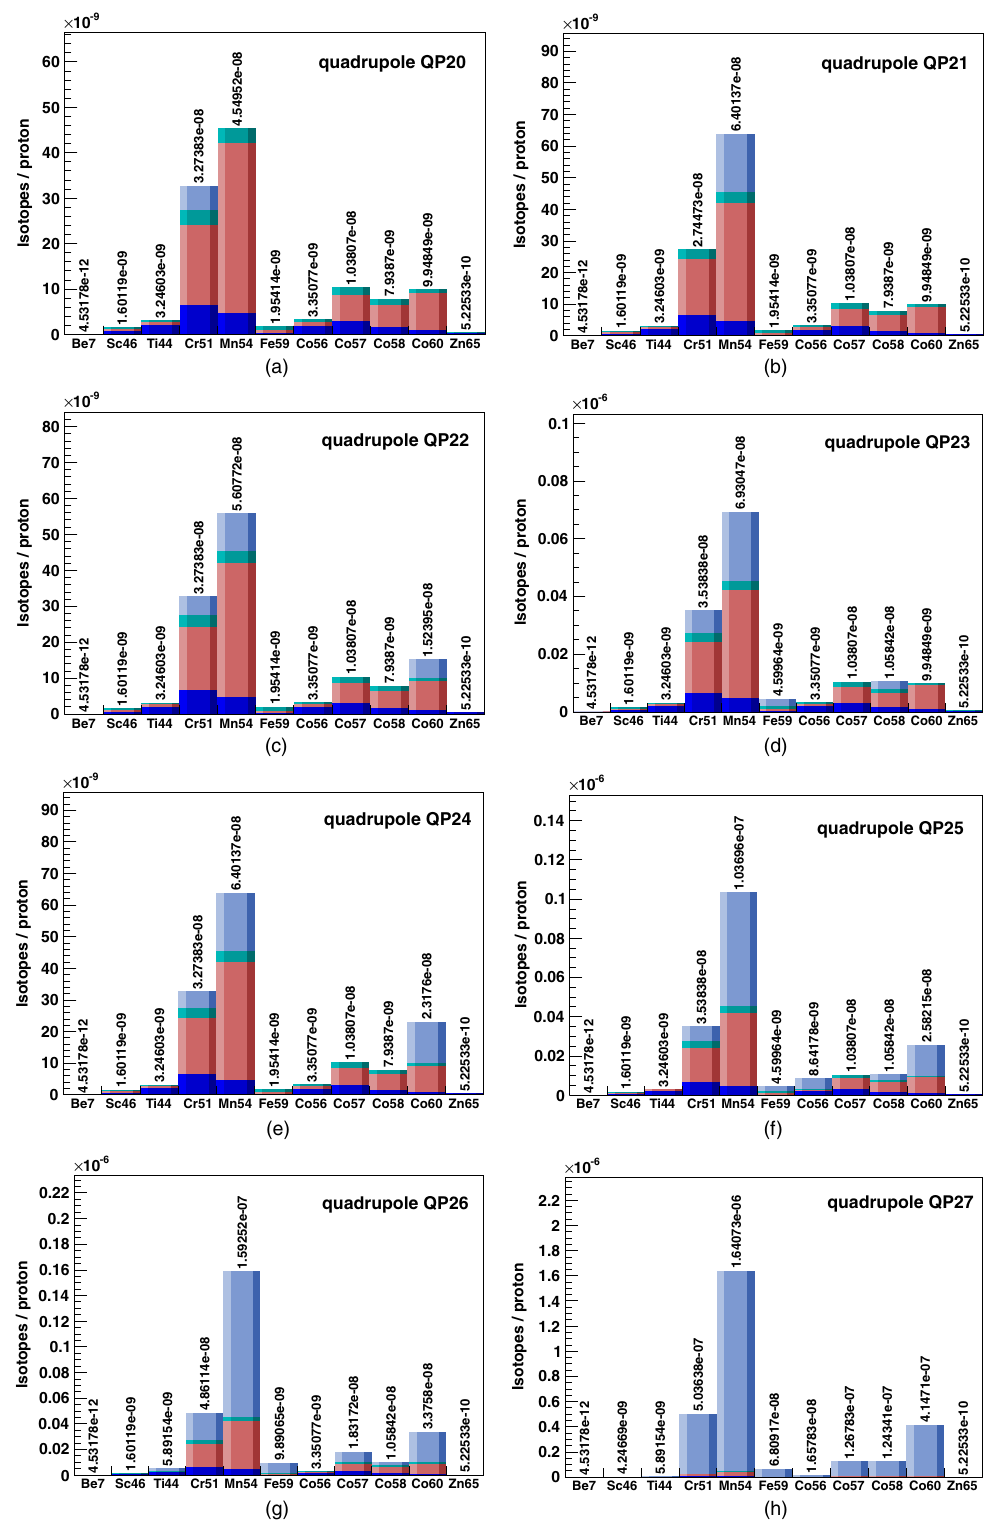
FIG. 7. The radionuclide inventory for the HEBT-S3 quadrupoles: (a) quadrupole QP20, (b) quadrupole QP21, (c) quadrupole QP22, (d)quadrupoleQP23,(e)quadrupoleQP24,(f)quadrupoleQP25,(g)quadrupoleQP26,and(h)quadrupoleQP27.Theisotopeyieldrepresents the total amount of particular isotopes found in the magnets. The colors represent isotopes produced by backscattered neutrons from the target (blue), isotopes produced in direct proton interactions (dark blue), isotopes produced in secondary neutrons interactions (red), and isotopes produced in other secondaries interactions